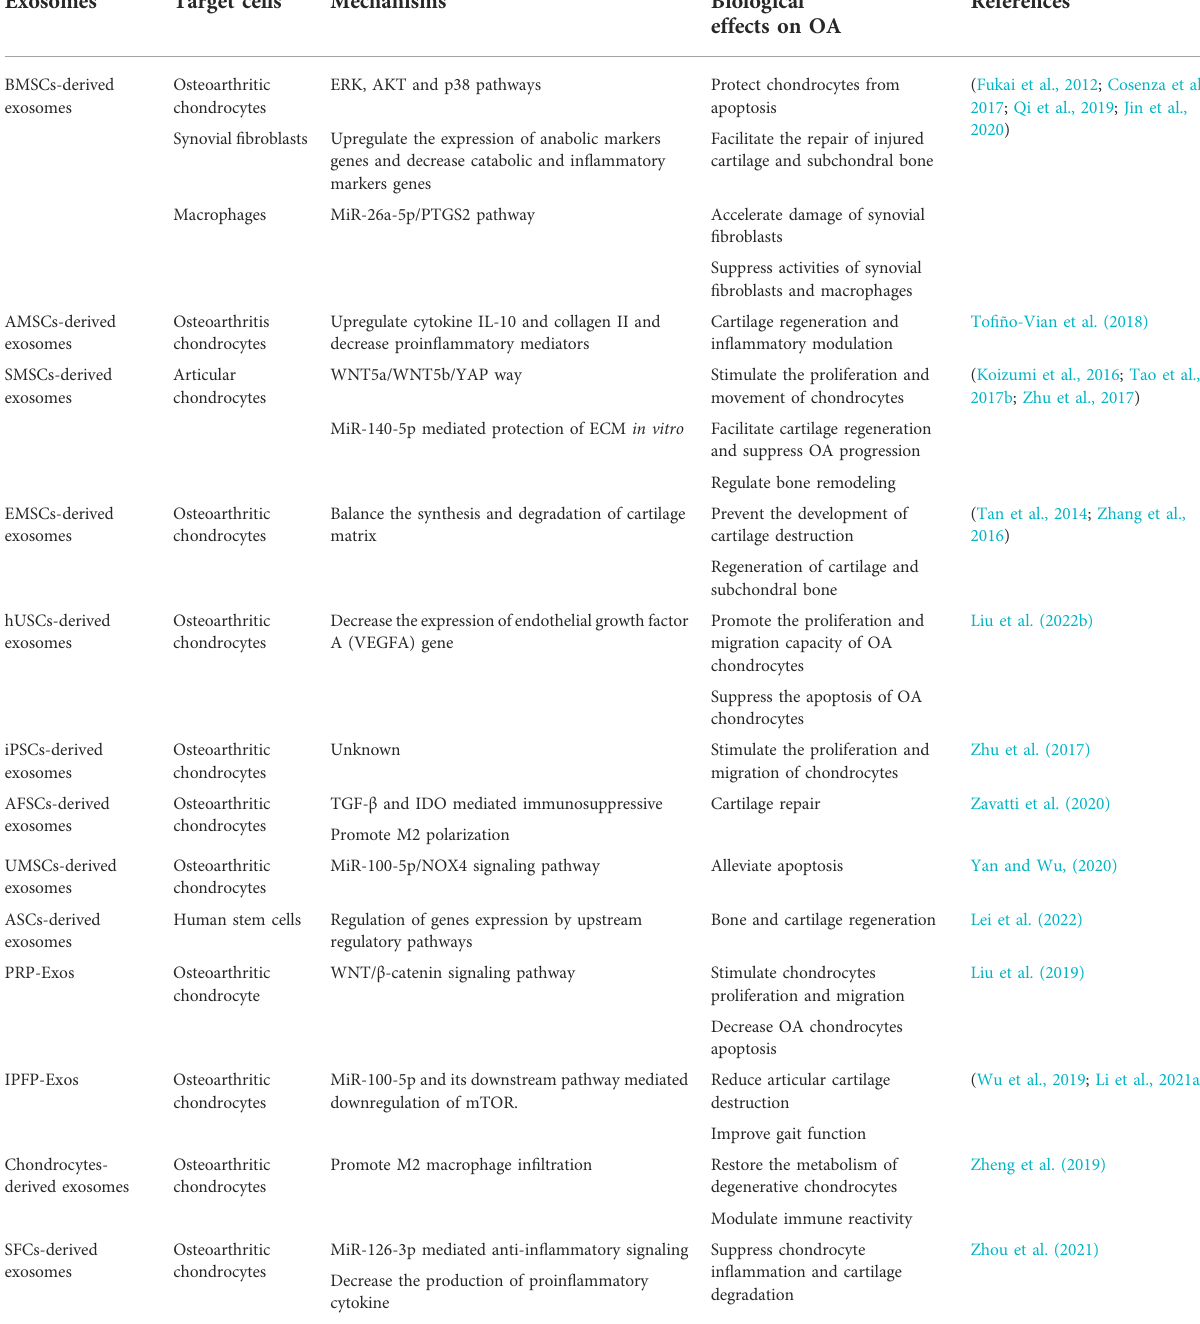
TABLE 2 Therapeutic effects of exosomes in